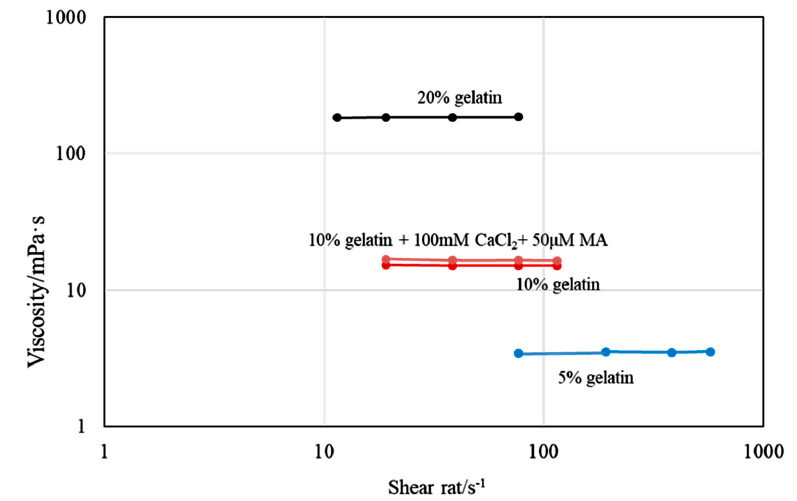
Figure 1. The viscosity of the gelatin solution as a function of gelatin concentration.